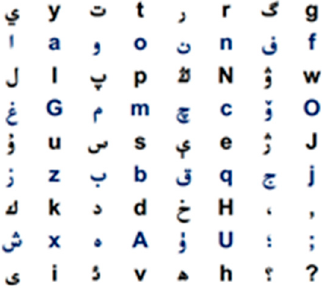
Figure 4. The correspondence of Uyghur language and Latin.